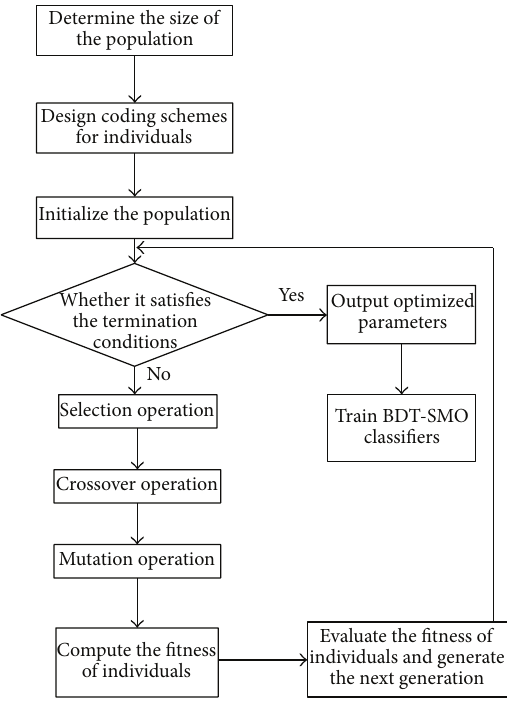
Figure 3: GA-based parameter optimization steps for BDT-SMO.